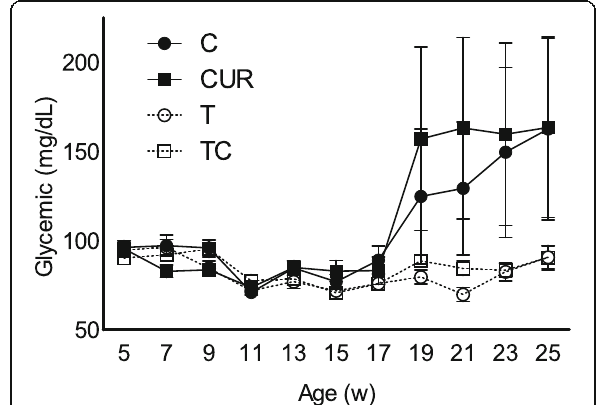
Fig. 1 Blood glucose during the 20-week experimental protocol from control ( C ), curcumin ( CUR ), trained ( T ), and trained + curcumin ( TC ). NOD mice were 5 weeks old at the beginning. Data are mean±standard